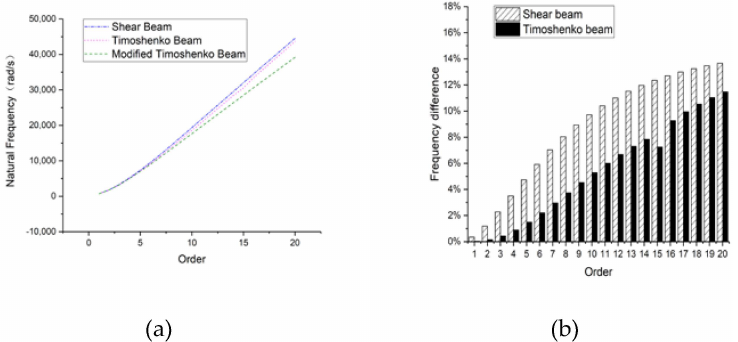
Figure 25. Natural frequencies of the 8-m-long beam: ( a ) overall frequency curve and ( b ) frequency di ff erence compared with a modified Timoshenko beam.